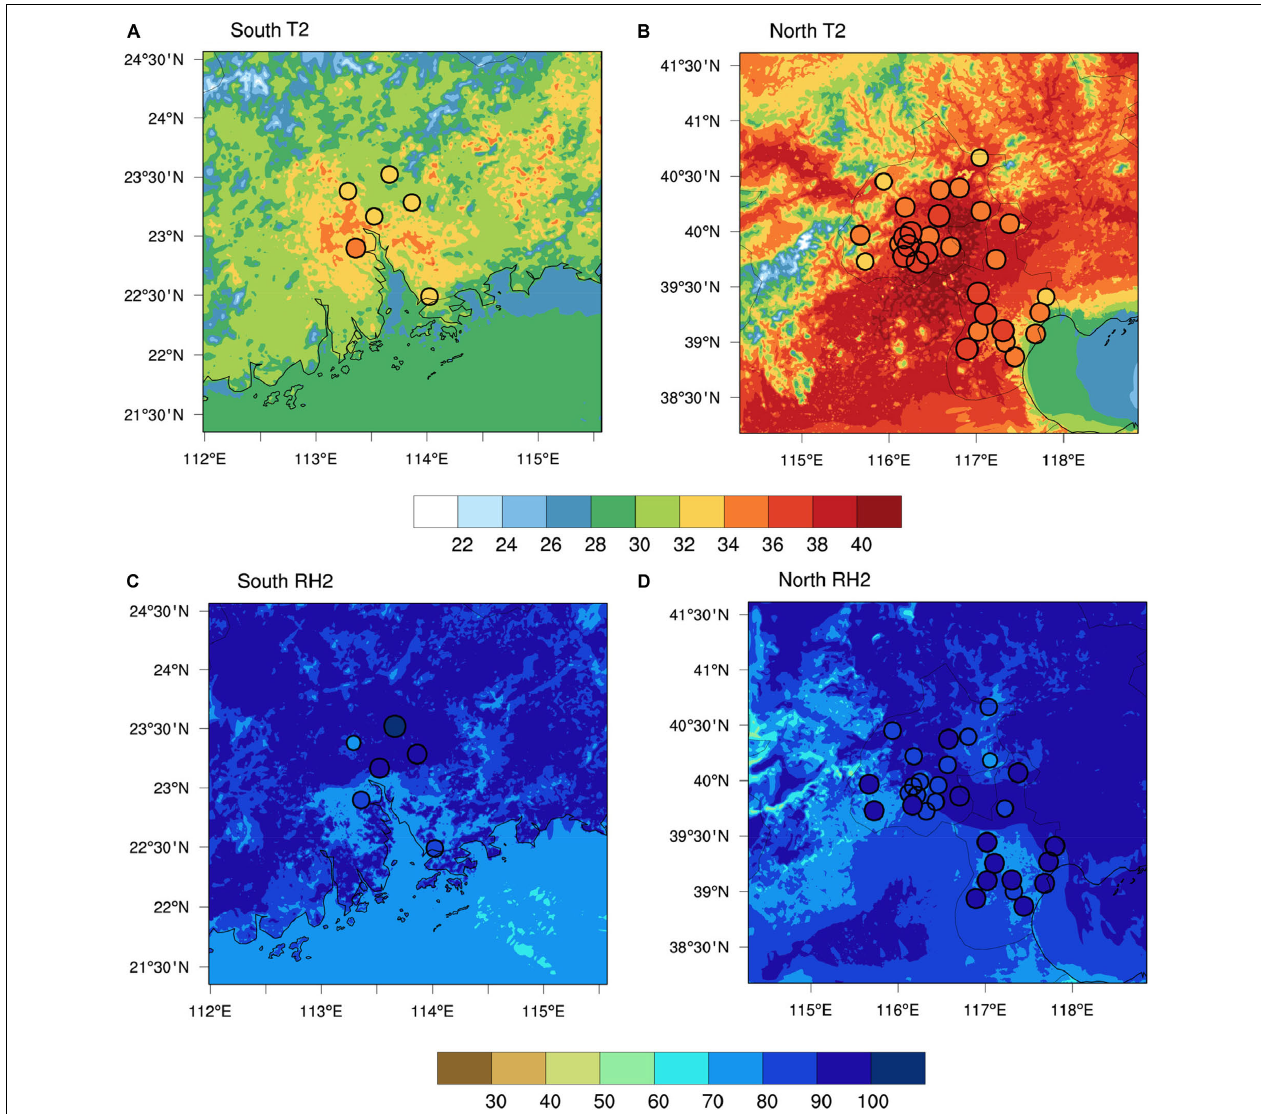
FIGURE 3 | (A–D) The spatial charts of observed (shaded circles) and simulated (shaded) 2-m air temperature ( ◦ C) at 05 UTC and relative humidity (%) at 21 UTC 27. All these observations are from the national surface AWS system network, with station locations shown by circles. Where the shaded circles have sizes proportional to temperature and humidity (cf. the color scales below A-D ).